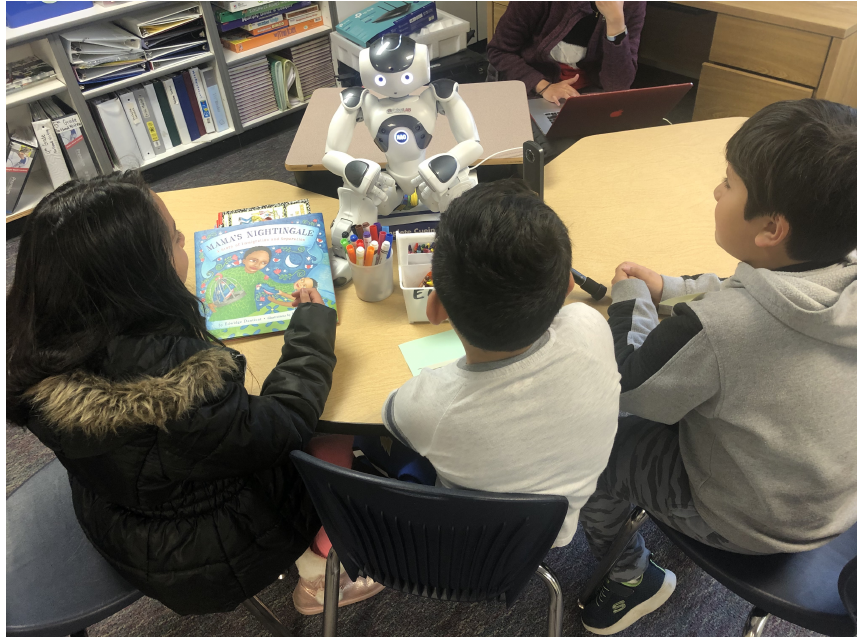
Figure 1. In this image, Nao is sitting on a book in the center of a table facing three ELL participants. The robot operator can be seen off to the side using a laptop to operate the